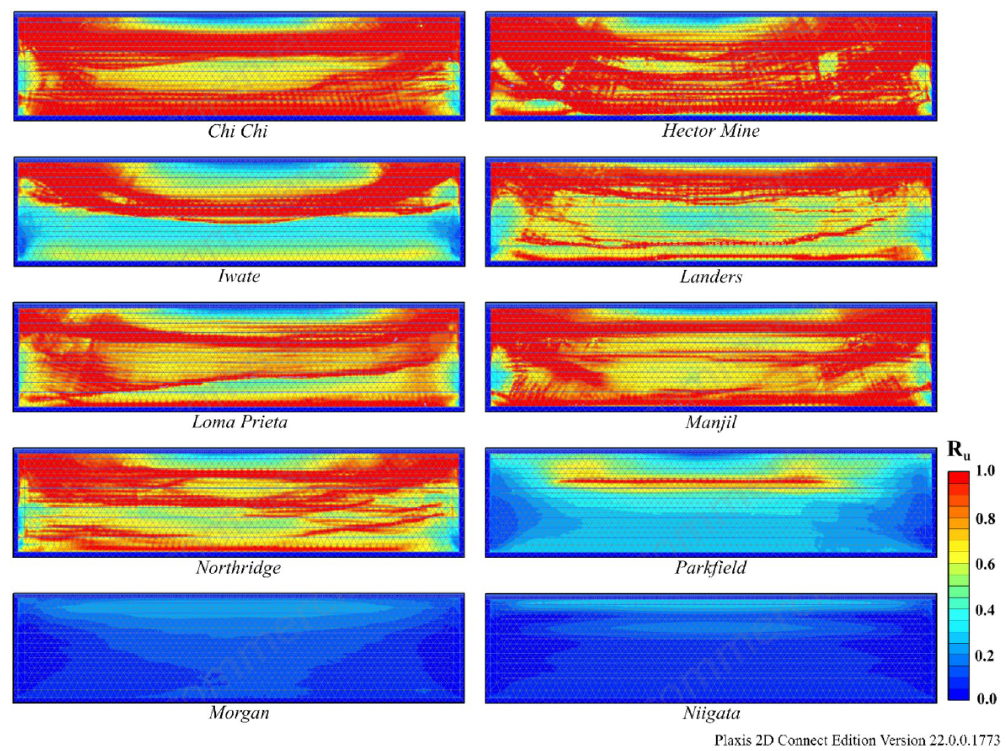
Figure 17. R u results obtained at the end of the vibrations for Model